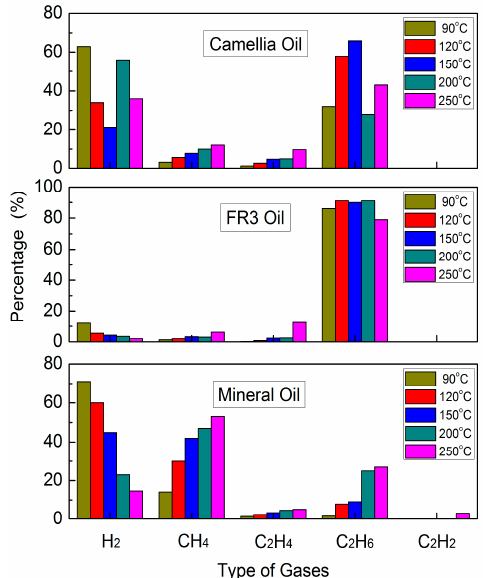
Figure 7. Relative percentages of fault gases in oil as a function of oven temperature (from 90 °C to 250 °C).